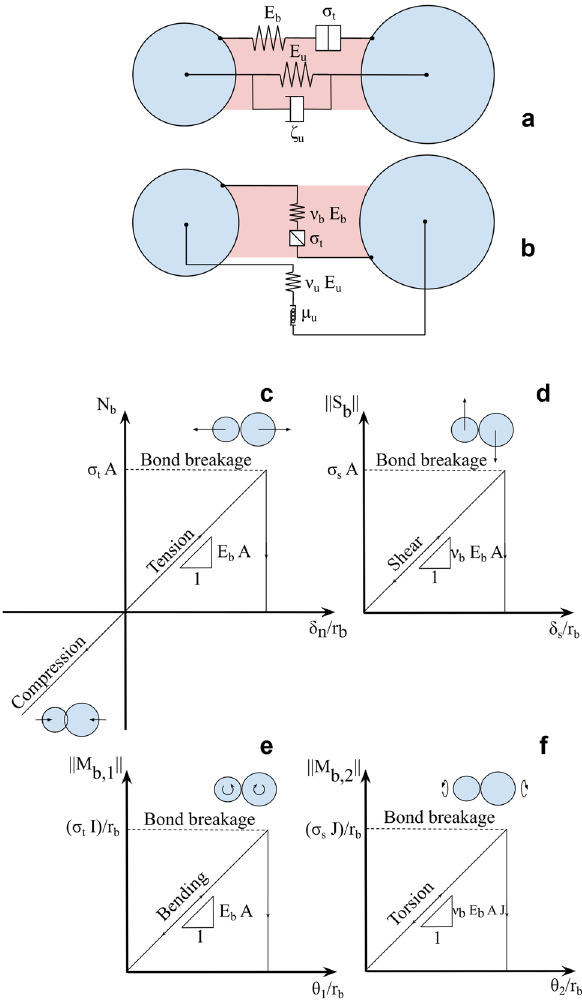
Figure 8. PFC3D parallel bond model (PBM) representation and its bonded behavior. ( a ) Normal mechanical parameter bonded and unbonded, where E b represents the bond elastic modulus, σ t the tensile strength, E u the contact elastic modulus and ζ u the contact damping ratio. ( b ) Shear mechanical parameter bond and unbonded, where E b represents the bond elastic modulus, σ s the shear strength, E u the contact elastic modulus, ν b the bond Poisson’s ratio, ν u the contact Poisson’s ratio and µ u the friction coefficient. To reduce the number of variables σ t (cid:31) σ th ν u ν b . ( c ) Bond normal force N b as a function of the E b (cid:31) E particle , σ s we assume E u bond and = = = S b normal interpenetration δ n scaled by the bond radius r b . ( d ) Bond shear force as a function of tangential (cid:31) (cid:31) M b ,1 interpenetration δ s scaled by the bond radius r b . ( e ) Bond-bending moment as a function of bending M b ,2 rotation θ 1 scaled by the bond radius r b . ( f ) Torsion moment as a function of twist rotation θ 2 scaled by (cid:31) (cid:31) (cid:31) (cid:31) the bond radius r b (cid:31) (cid:31) (cid:31) (cid:31)